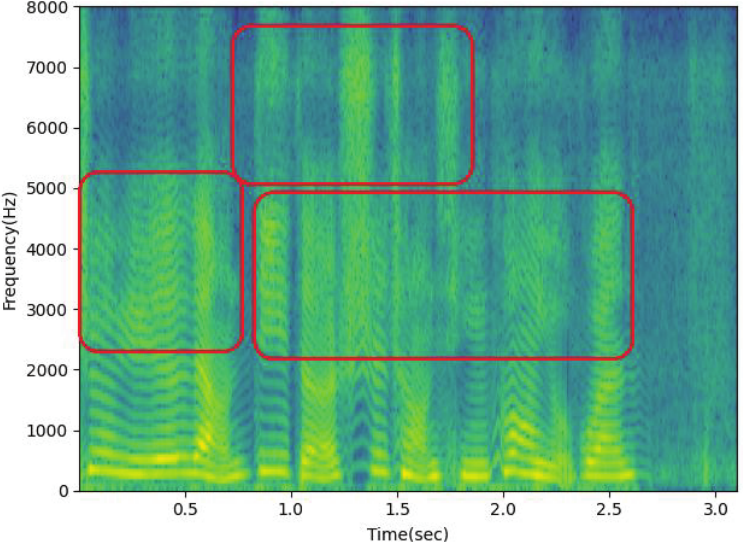
Figure 8. Enhanced BC speech spectrogram by